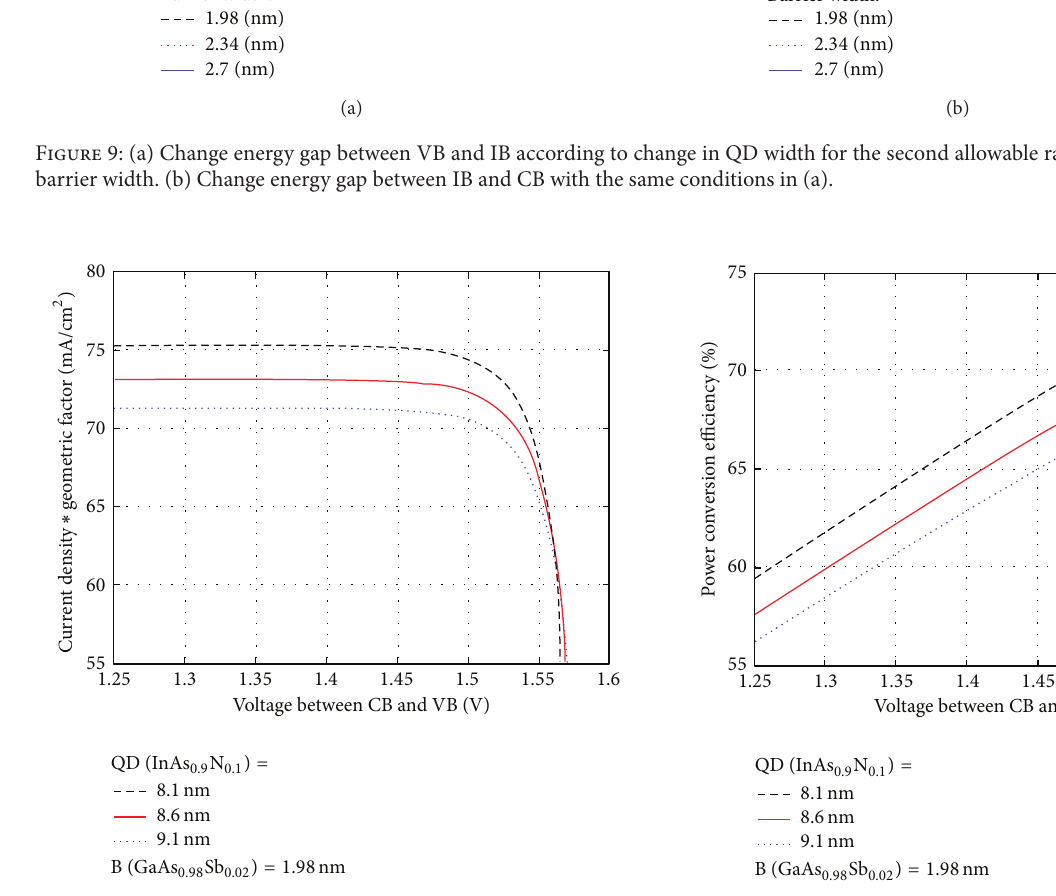
Figure 11: Power conversion efficiency for QDIBSC at full concen- tration with varying the quantum dot width and barrier width held